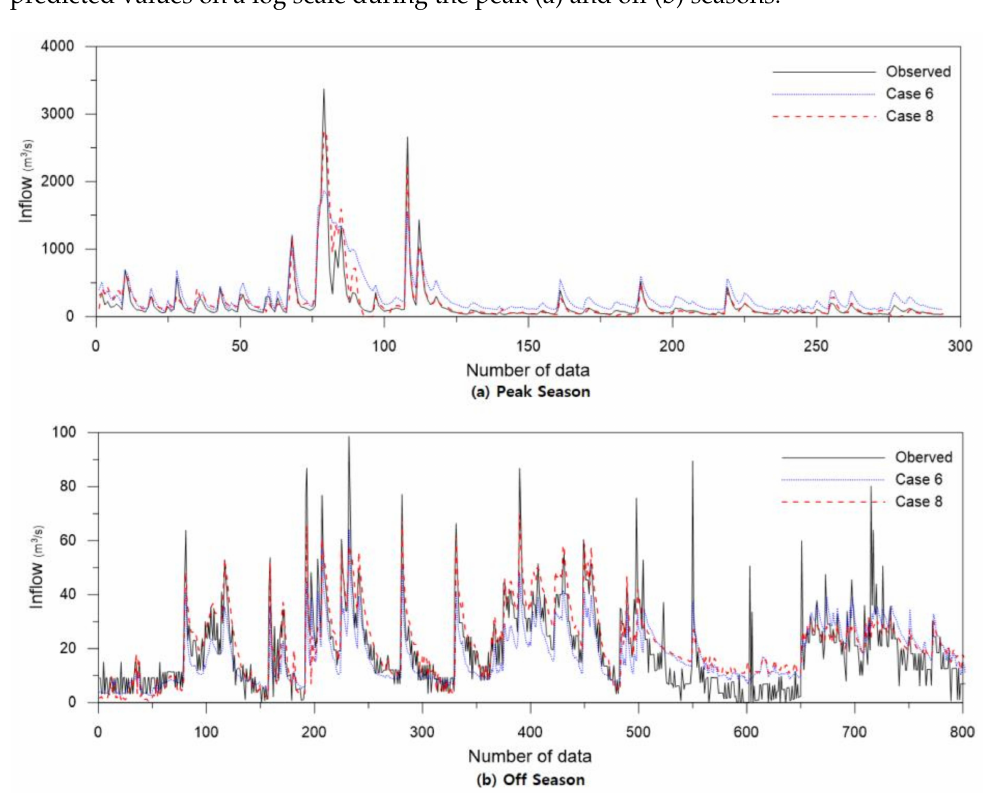
Figure 11. Results of applying both normalization and seasonal division (Case 8) and seasonal division only (Case